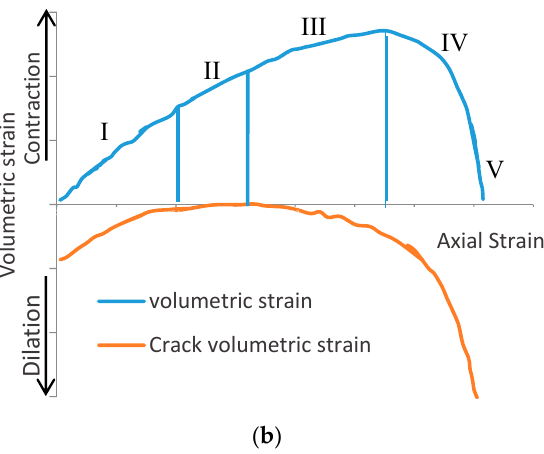
Figure 7. ( a ) Typical stress-axial strain development of rock under brittle failure [80]; ( b ) Variation of volumetric strain with Axial strain under brittle failure [77].